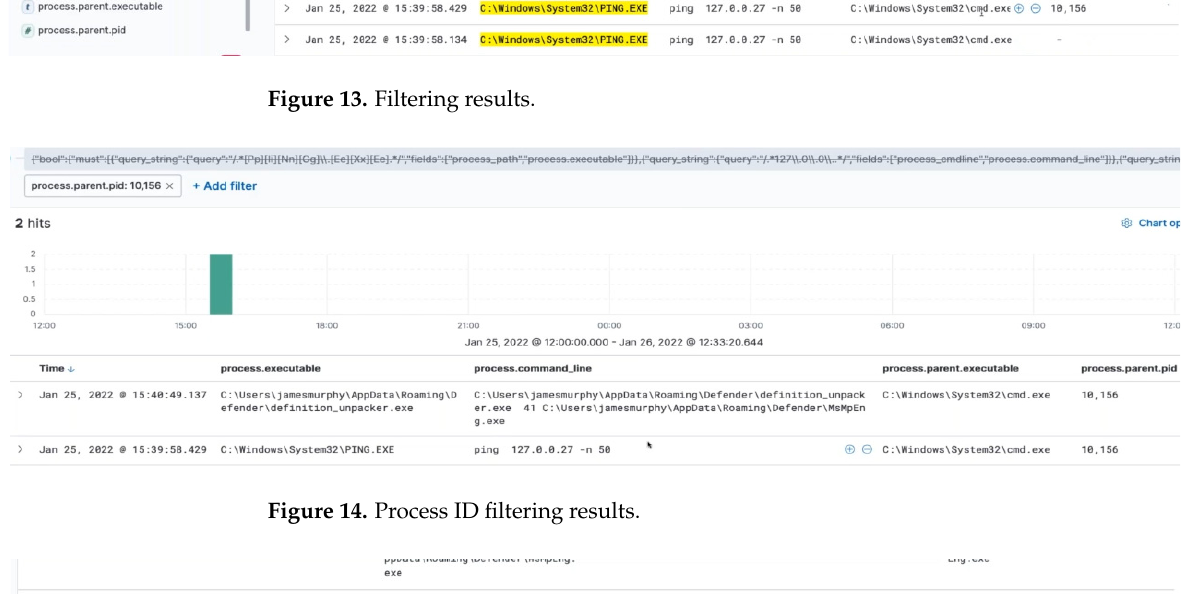
Figure 13. Filtering results.